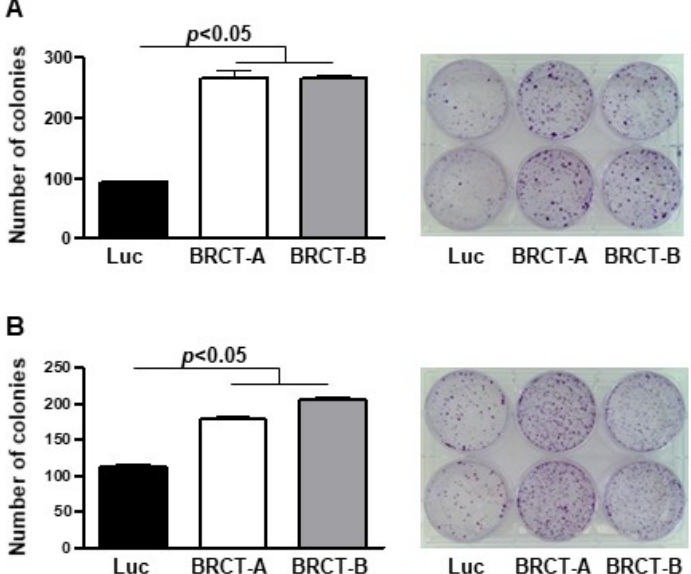
HEK293T cells. These results pointed out to a potential tumorigenic effect of BRCT domain from LmjPES protein.